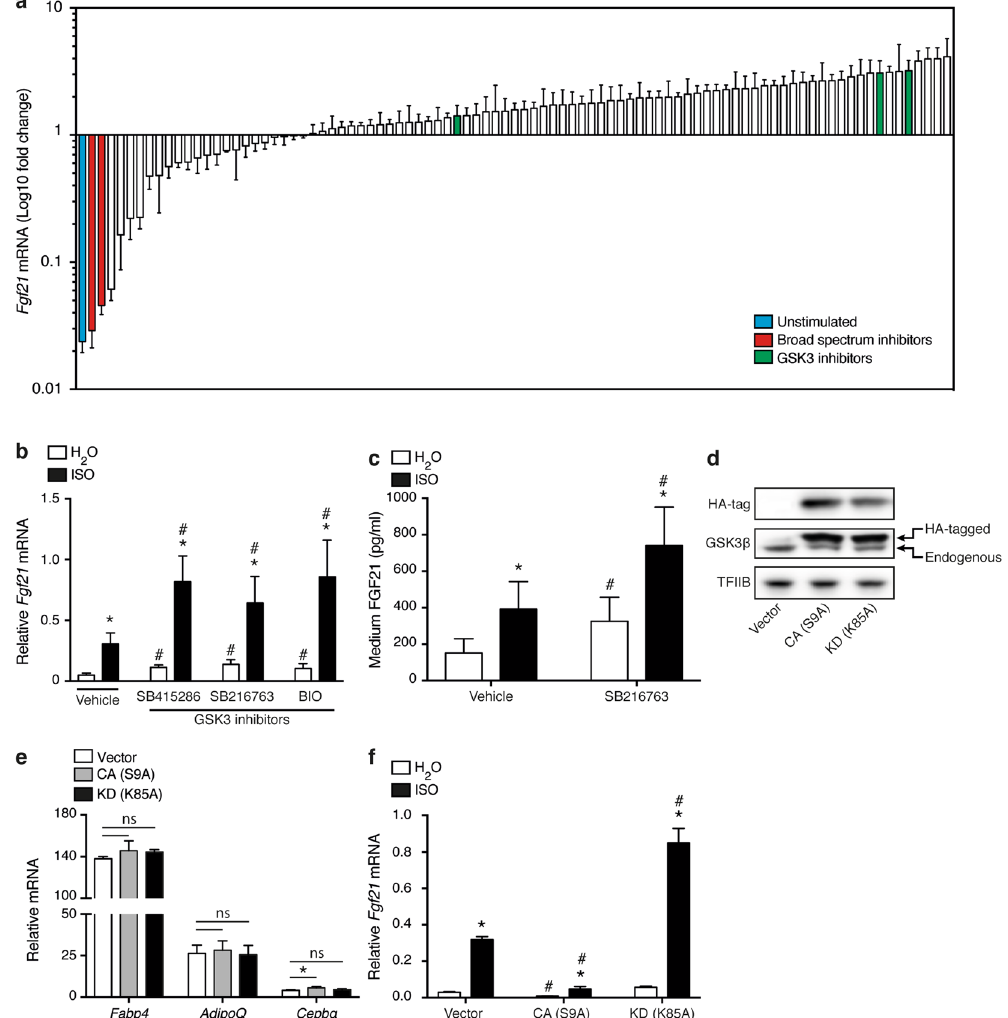
Figure 2. GSK3 is a negative regulator of Fgf21 expression and secretion in brown adipocytes. ( a ) Kinase inhibitor screen to identify novel regulators of Fgf21 expression in response to β -adrenergic stimulation. Fgf21 expression in mature immortalized brown adipocytes pre-treated with 10 μ M kinase inhibitor for 1 h before stimulation with 0.1 μ M ISO for an additional 6 h. Unstimulated (blue) and broad spectrum inhibitor-treated cells (red) serve as controls. Green columns show cells pre-treated with GSK3 inhibitors. ( b ) Fgf21 mRNA levels in mature immortalized brown adipocytes pre-treated with 10 μ M of the GSK3 inhibitors SB415286, SB216763 and BIO for 1 h before being stimulated with 0.1 μ M ISO for additional 6 h. ( c ) Secreted FGF21 in cell culture medium from immortalized brown adipocytes pre-treated with 10 μ M SB216763 for 1 h before stimulation with 0.1 μ M ISO for an additional 24 h. ( d ) Immunoblot against HA-tag and total GSK3 β in immortalized brown adipocytes overexpressing constitutively active (CA) or kinase dead (KD) GSK3 β or empty vector. TFIIB serves as loading control. Full-length blots/gels are presented in Supplementary Fig. 2. (e) Expression of differentiation markers ( Fabp4 , AdipoQ and Cebp α ) in immortalized brown adipocytes after ectopic overexpression of GSK3 β mutants. ( f ) Fgf21 expression in immortalized brown adipocytes overexpressing GSK3 β mutants or empty vector. Mature adipocytes were treated with 0.1 μ M ISO for 6 h. Data represents mean of means + SEM from 3 independent experiments. Statistical significance was determined by two-way ANOVA with repeated measures and Tukey’s post hoc test for multiple comparisons. * p < 0.05 versus H 2 O. # p < 0.05 versus vehicle/vector control. No statistical tests were applied to panel